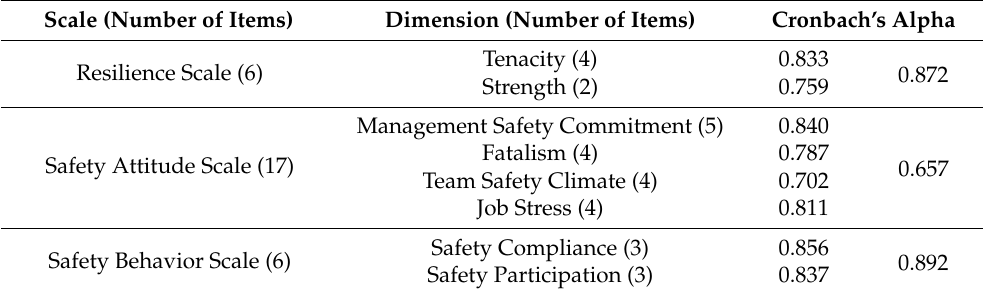
Table 4. Results of the reliability test of the three scales.